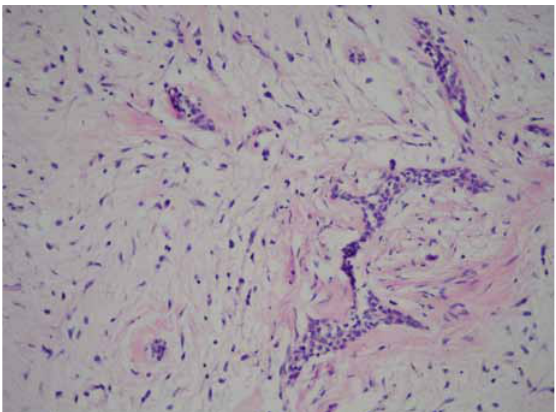
Figure 3. Histopathological image. HE. 200x